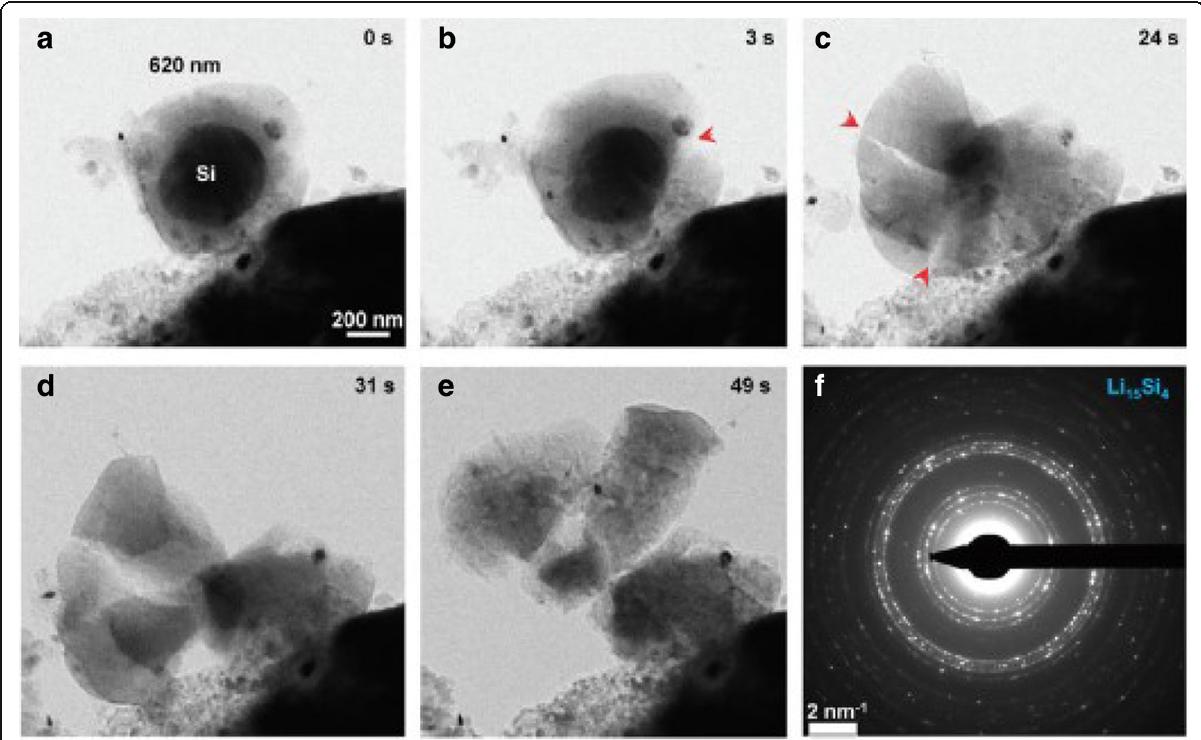
Fig. 3 Fast deformation of a free-standing 620-nm SiNP during chemical lithiation in 1 min. a – e Time sequence of crack initiation and growth. f EDP indicating the formation of polycrystalline Li 15 Si 4 as the fully lithiated